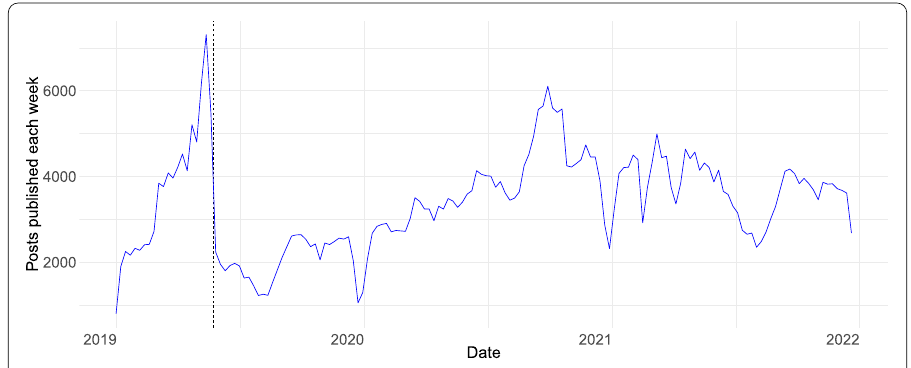
Figure 3 The total number of posts published. The vertical line represents the 2019 European